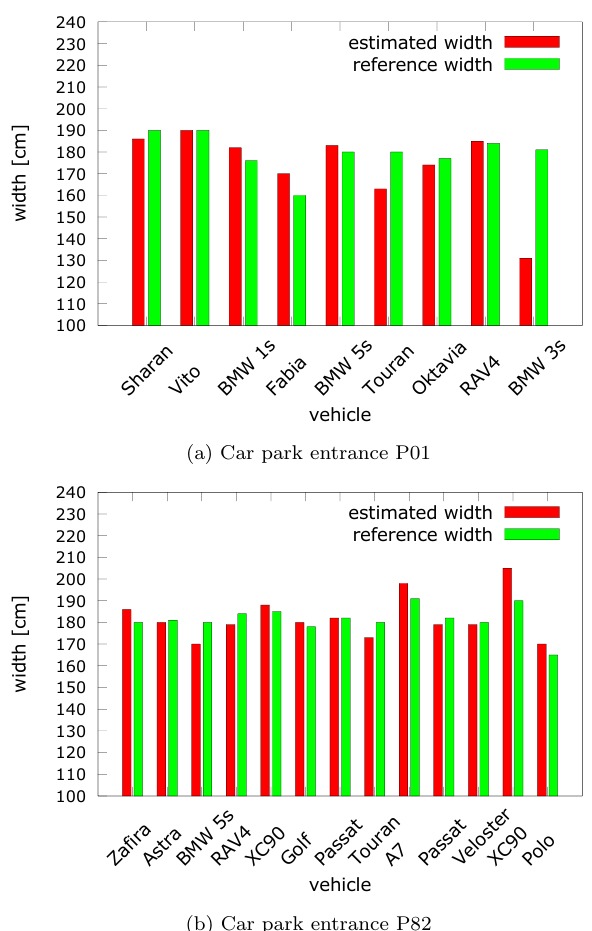
Figure 9: Comparison of the measurement and reference values for the width measurement with dynamic reference